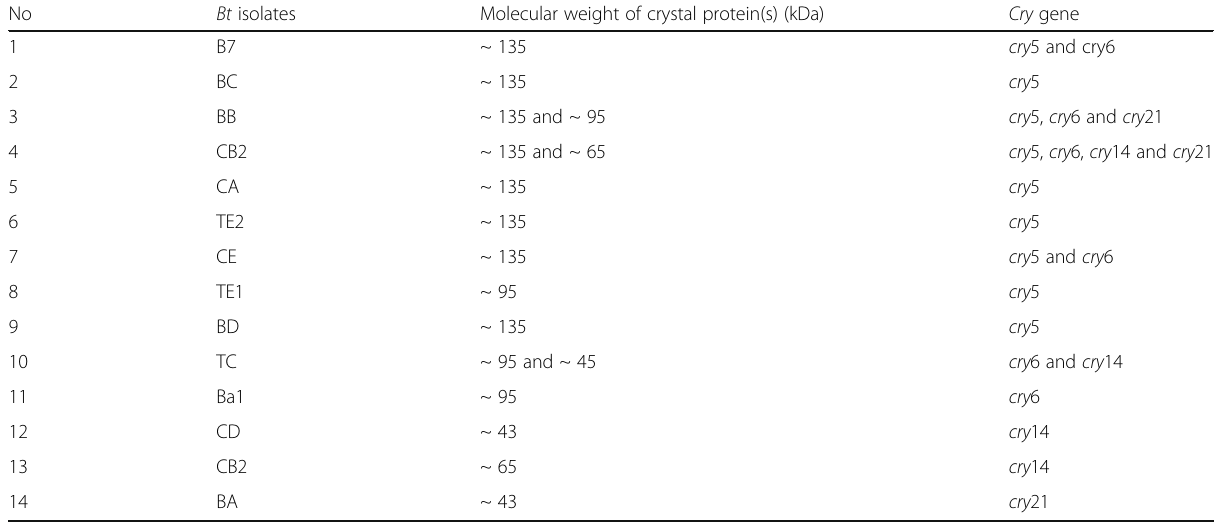
Table 1 Nematicidal cry gene profiles and molecular weight of crystal proteins of native isolates of Bacillus thuringiensis No Bt isolates Molecular weight of crystal protein(s) (kDa) Cry